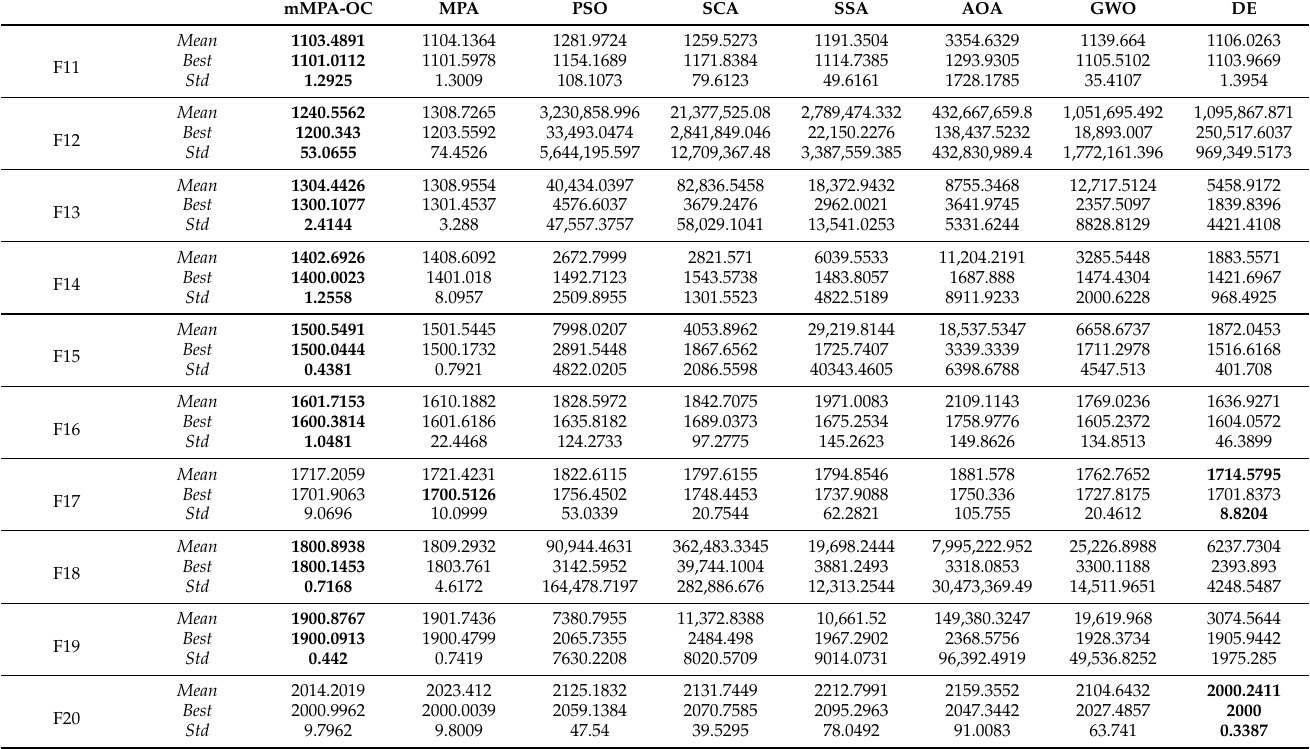
Table 4. Comparison of experimental results on CEC-2017 (10 dimensions) Hybrid function.